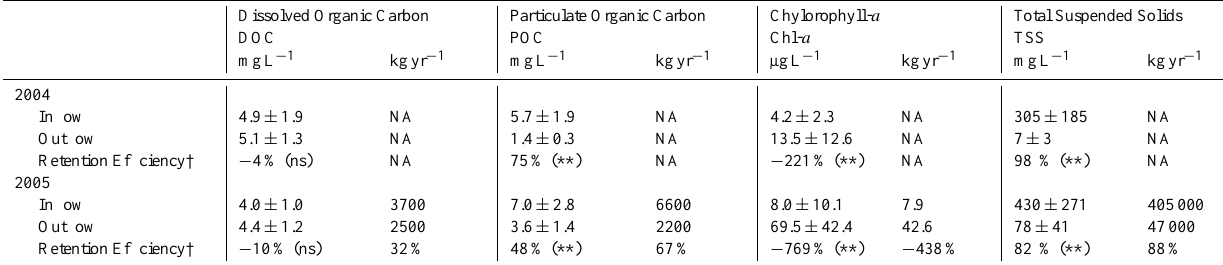
Table 1. Seasonal mean concentration of C constituents at inflow and outflow locations in 2004 and 2005 (mean ± standard deviation). Dissolved Organic Carbon Particulate Organic Carbon Chylorophyll- a